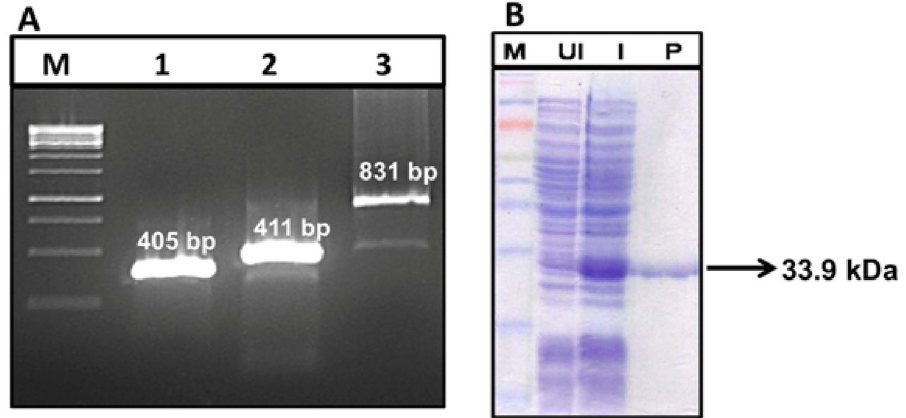
Figure 1. Construction and expression of r-PB. ( A ) Agarose gel electrophoresis of nucleotide fragments; bclA 1 (bclACTD) (Lane 1); pag (Domain IV) (Lane 2); PB (Lane 3). ( B ) SDS-PAGE of whole cell lysate from un- induced and IPTG induced r-PB recombinant E.coli clones stained with Coomassie Blue: UI: Un-induced clone, I: Induced Clone, P: r-PB purified